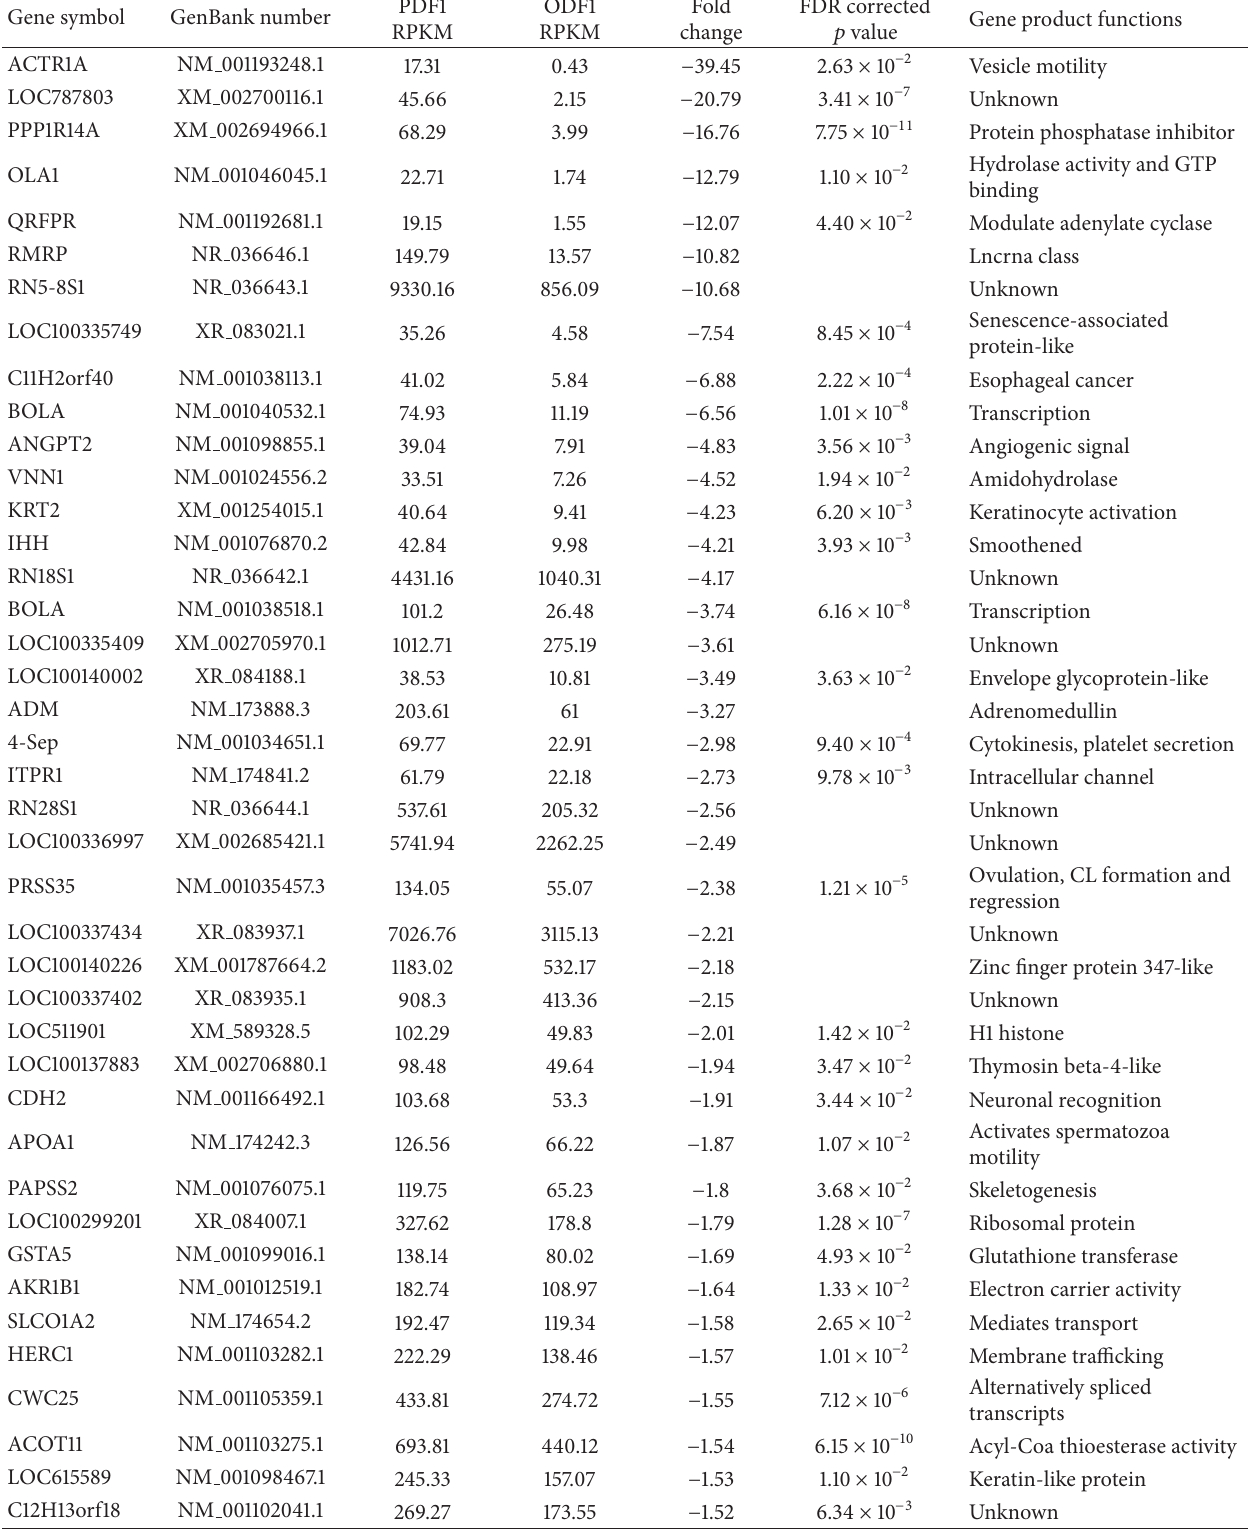
Table 2: List of downregulated genes in ODF1 versus PDF1 and their